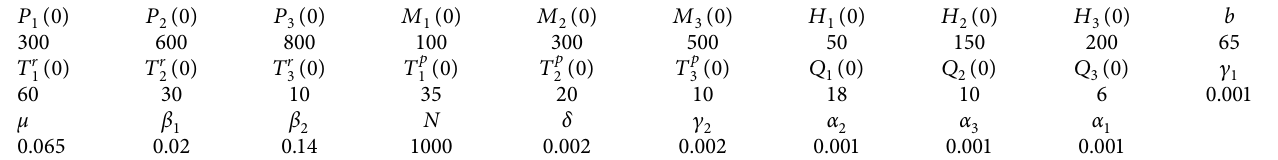
Table 2: The academic parameters used for model (1).